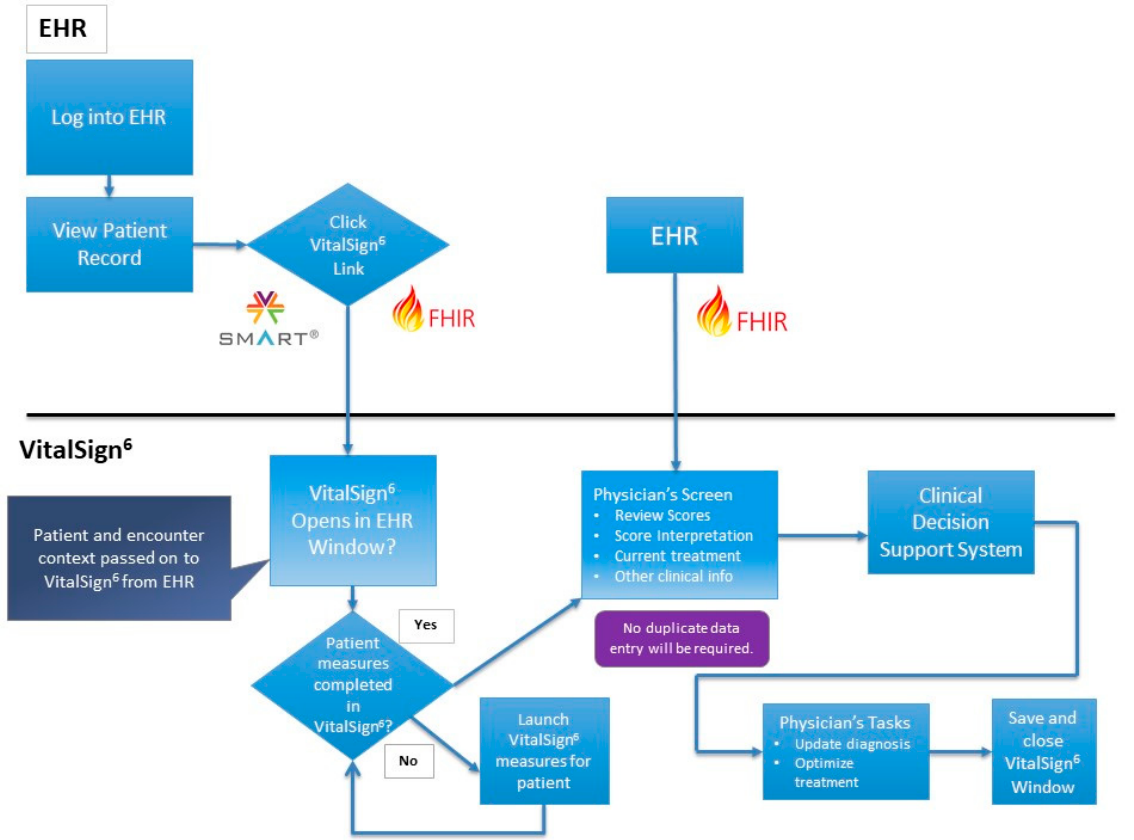
Figure 2. illustrates the practical application of the SMART (Substitutable Medical Apps and Reusable Technology) on FHIR (Fast Healthcare Interoperability Resources) technology, which allows VS 6 to become integrated directly into the electronic health record (HER) user